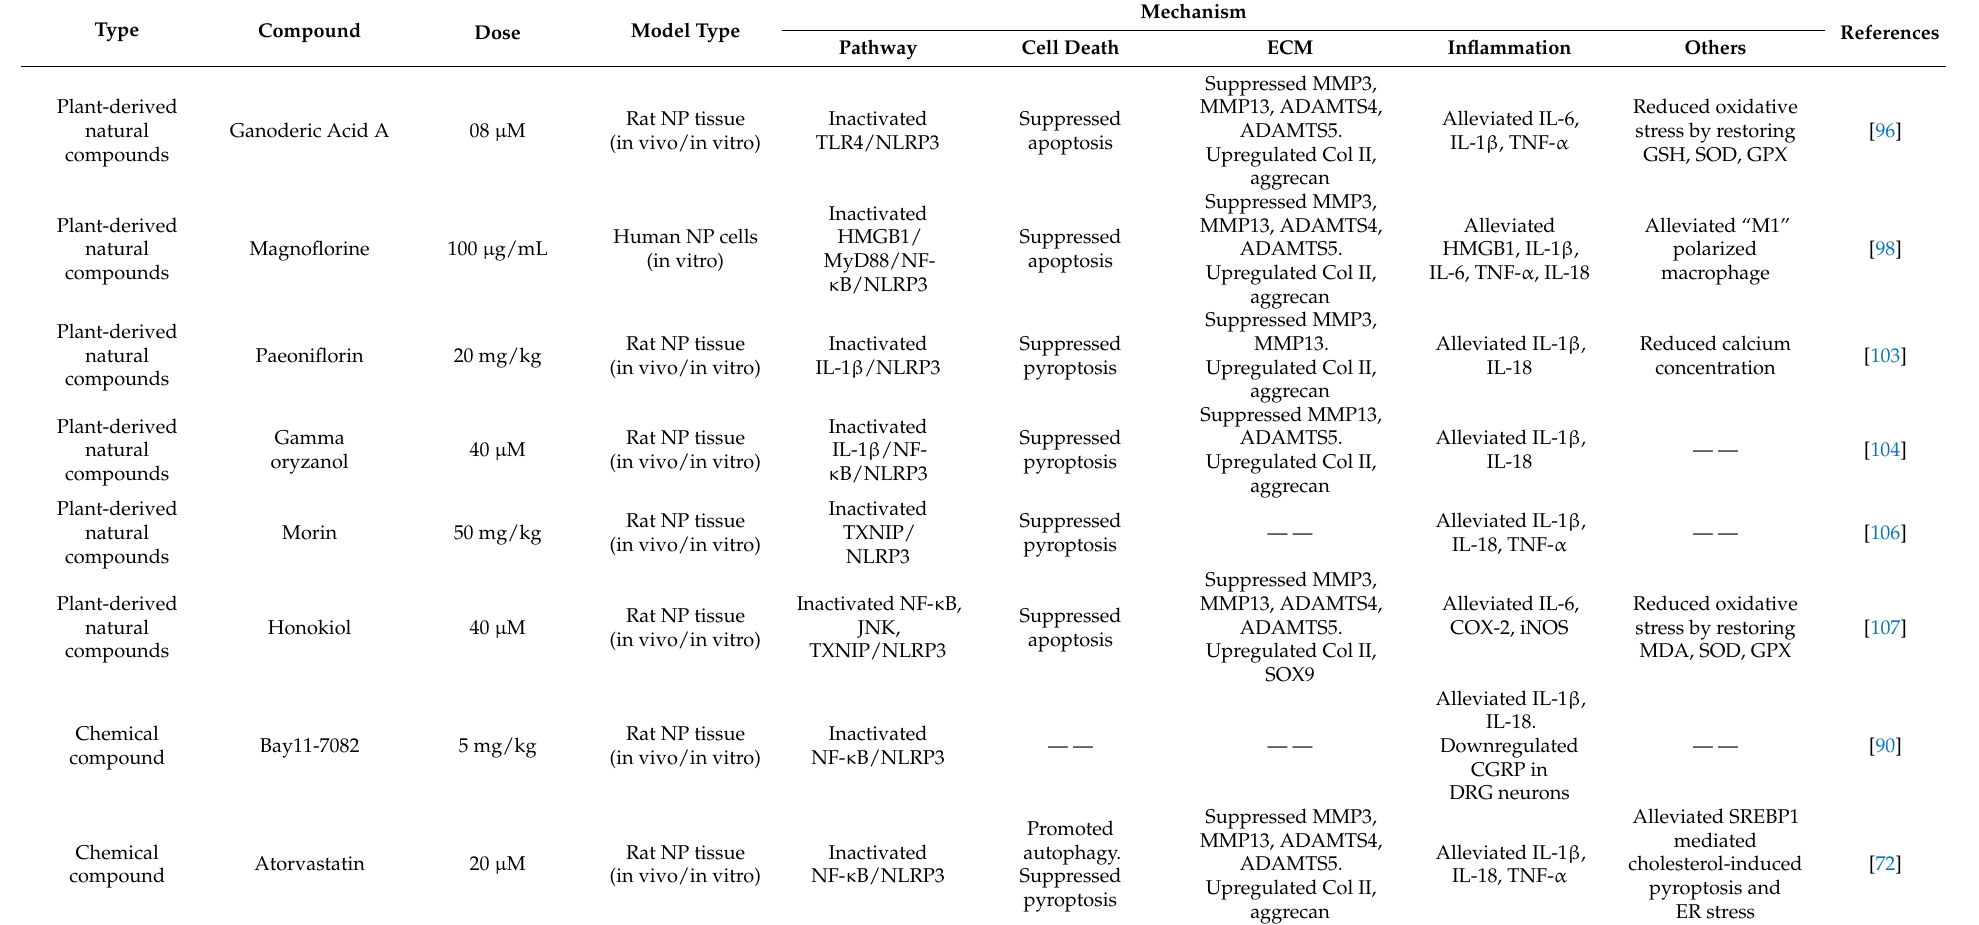
Table 1. Mechanisms of exogenous compounds for IDD treatment by inactivating